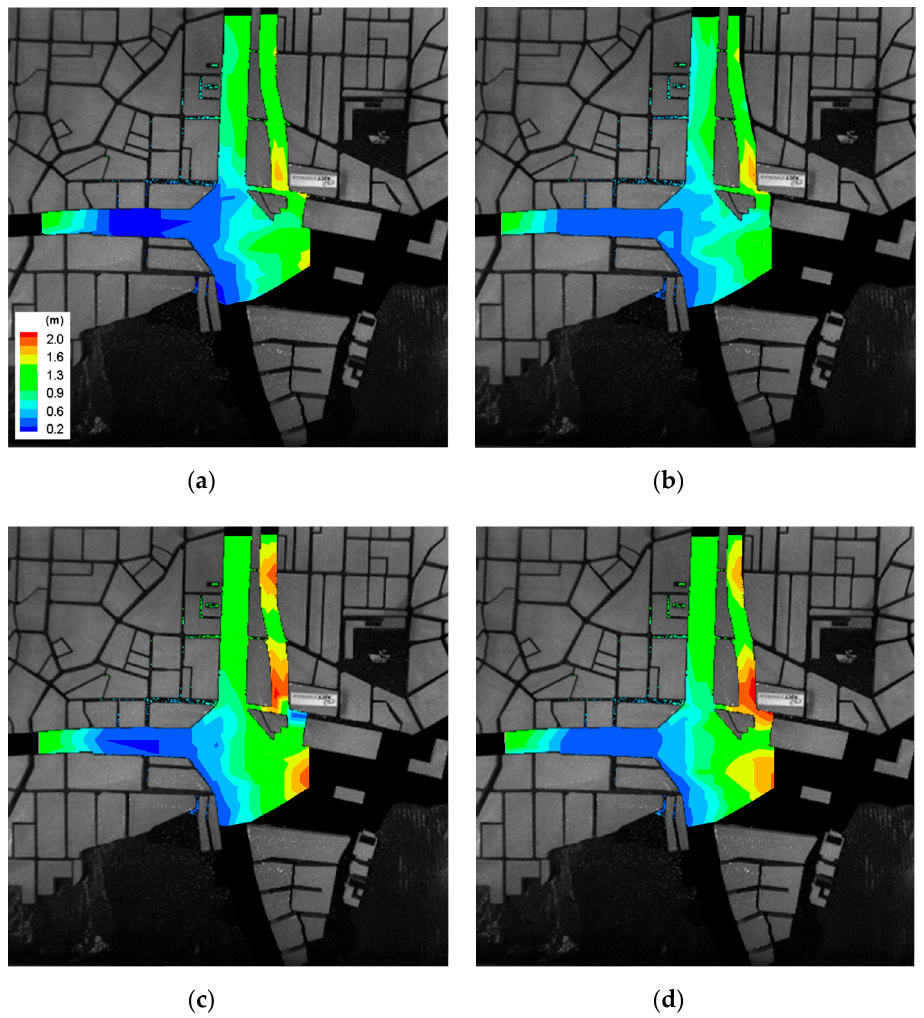
Figure 7. Inundation depth changes according to rainfall intensity: ( a ) 80 mm / h; ( b ) 130 mm / h; ( c ) 160 mm / h; ( d ) 185 mm / h.